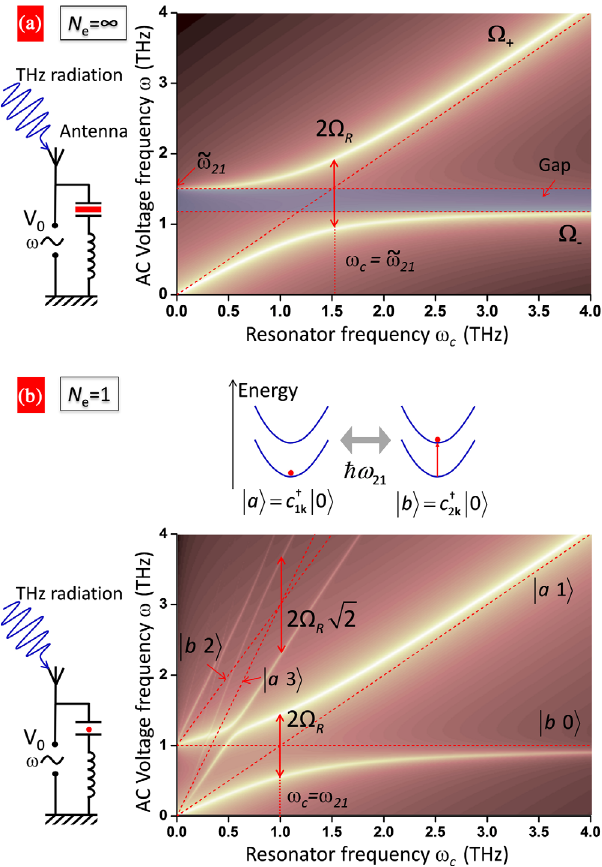
FIG. 5. (a)Absorptionspectrumofan LC circuitcoupledwiththe 2DEG of the quantum well. The vertical ( y ) axis is the frequency of the probing voltage, the horizontal ( x ) axis is the frequency of the resonator ω c , and the color code ( z axis) is the strength of the absorption signal, on a logarithmic scale. Details of the compu- tation are provided in Appendix C 2. In this case, the circuit is coupled with the intersubband plasmon mode, and the typical anticrossing curves are seen. For this plot, the circuit-matter 0 . 77 ω coupling constant is 2 Ω R; 21 . (b)The same plotobtained eff ¼ forthecaseofasingleelectroninthecapacitor,asobtainedfromthe Rabi model (Appendix C